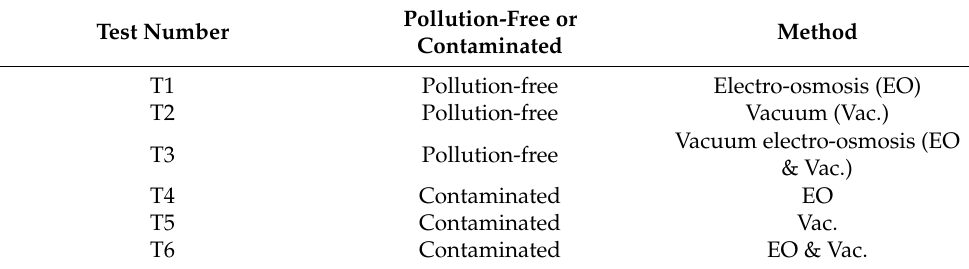
Table 2. Summary of basic parameters of each group.